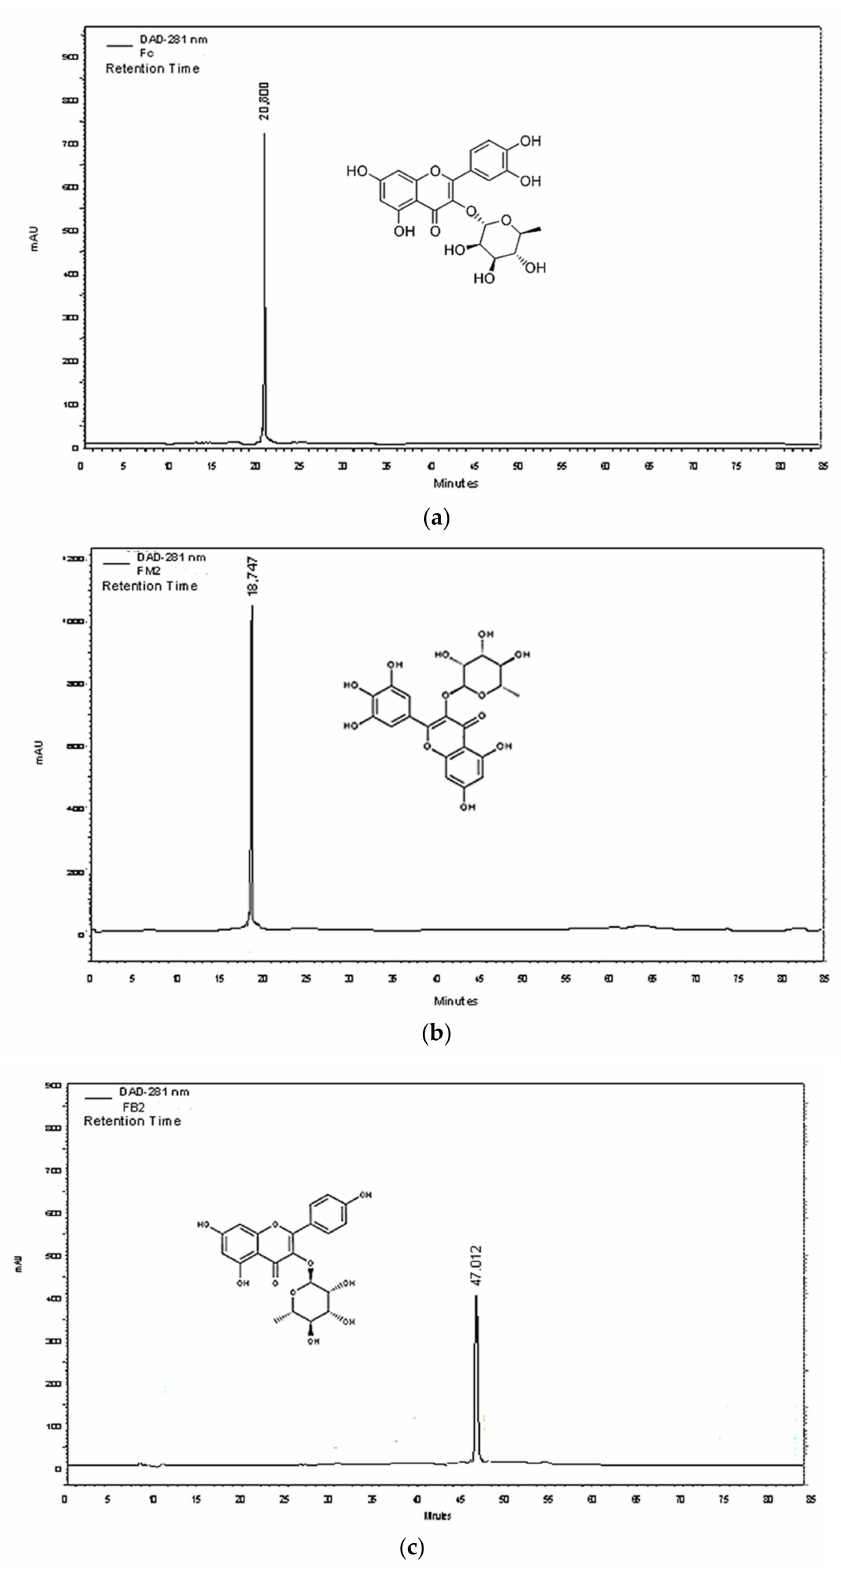
Figure 3. Chromatographic profile of ( a ) C fraction (Quercetin-3- O -rhamnoside), ( b ) M2 frac- tion (myricetin-3- O -rhamnoside), and ( c ) B2 fraction (kaempferol-3- O -rhamnoside) acquired by